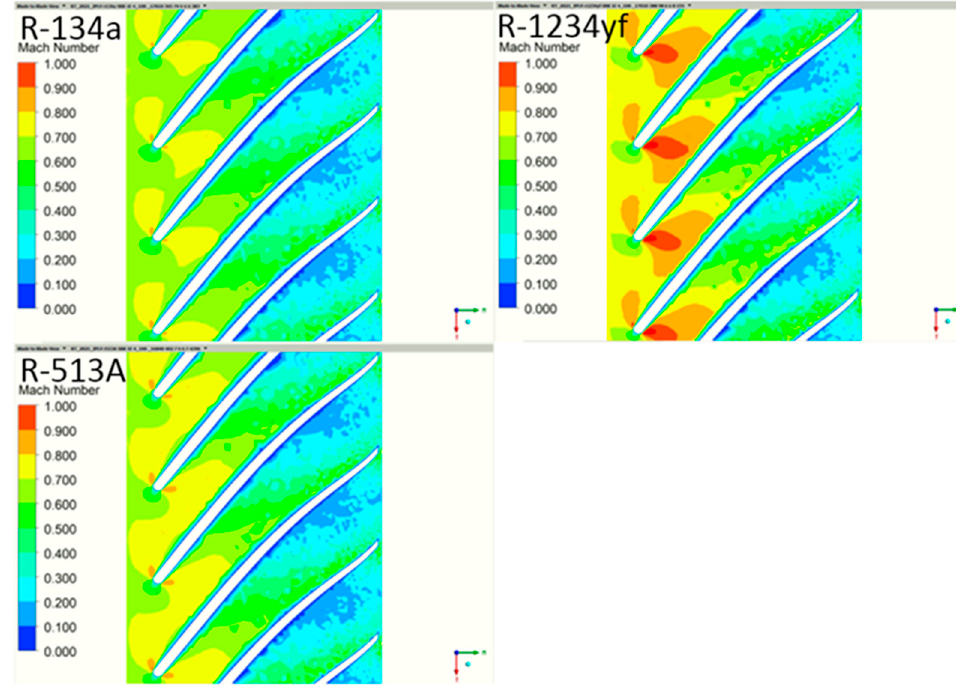
Figure 17. Numerical dispersion of Mach number of the inter-blade flow field of refrigerants.